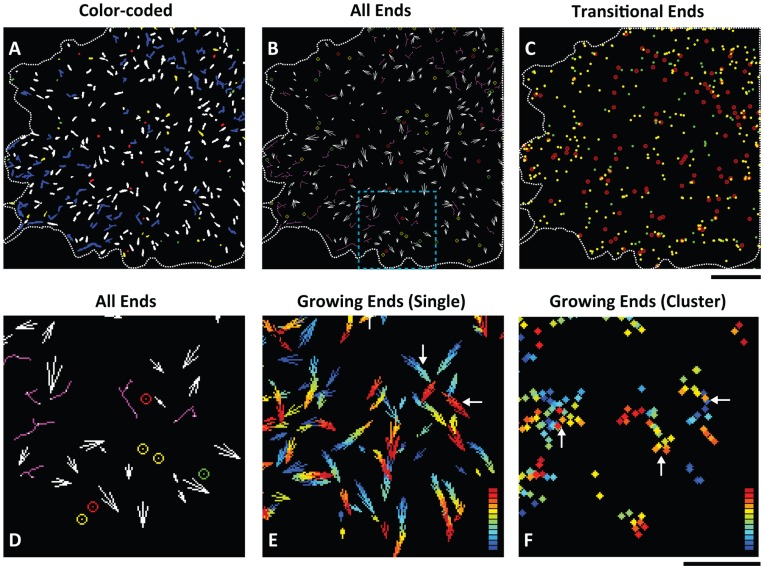
Quantitative analysis of microtubule dynamics in a COS cell. A.Spatial distribution of all dynamic microtubule ends identified at a single time point from a COS cell using the dCCD method (Figure S2). All ends are shown by their size and shape. The associated colors represent the dynamics groups each end belongs to: white for single growing ends, blue for clustered growing ends, red for rescued ends, green for those in catastrophe, and yellow for pausing ends. B. Visualization of microtubule ends in space by their dynamic properties in a single frame of the COS cell in (A). The centroids of three transitional events (red, green, and yellow) are shown in circles of corresponding colors. Single growing ends are shown in white growth vectors to indicate their growth direction (arrow orientation) and rate (arrow size), while clustered growing ends are shown in magenta skeletons with identified ends labeled by white dots. The dotted blue box indicates the region enlarged in (D–E). C. Centroids of microtubule ends undergoing rescue (red circles), catastrophe (green dots), and pause (yellow dots) in the same COS cell are pooled from 12 sequential frames and merged together to show their spatial distribution. D. High magnification picture from the boxed region found in (B). E. Visualization of single growing ends in time and space. Single growing ends identified in the boxed region in (B) are pooled together from 12 frames (1 min) and shown by their growth vectors. The associated color represents their frame sequence in reference to a color-based time map, in which blue indicates the first frame and red represents the 12th frame. Many ends aligned perfectly along their growth trajectory toward the cell periphery, revealing their continuous polymerization in the cell. Newly growing ends (red ends, horizontal arrow) are distinguishable from old ones (blue ends, vertical arrow). F. Visualization of clustered growing ends by their centroids in the boxed region in (B). Centroids from 12 frames (1 min) are shown in color based on a colored time map. Note many centroids are aggregated in patches (arrows). Scale bars: 10 µm for (A–C), 5 µm for (D–F).